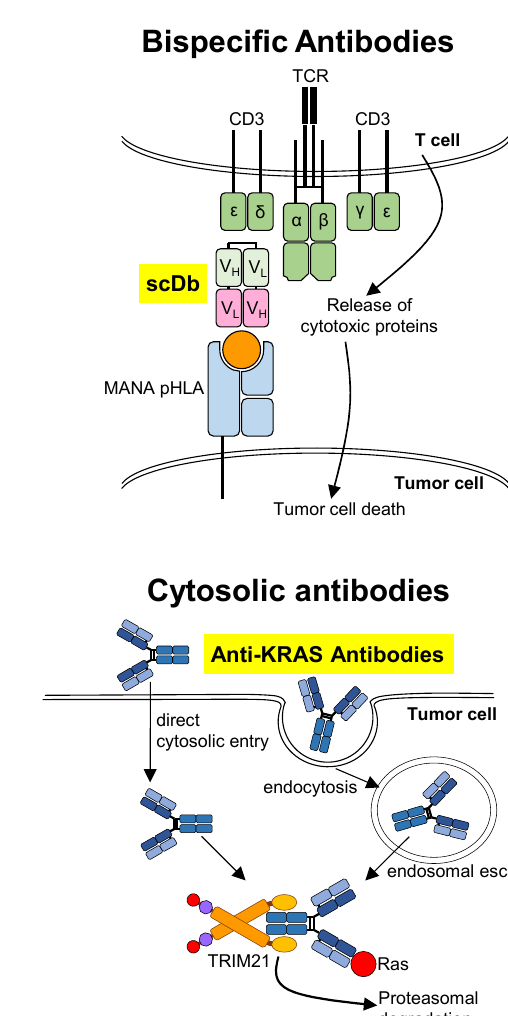
Figure 3. Biologics for Ras inhibition. Key components of the different approaches are highlighted (yellow).